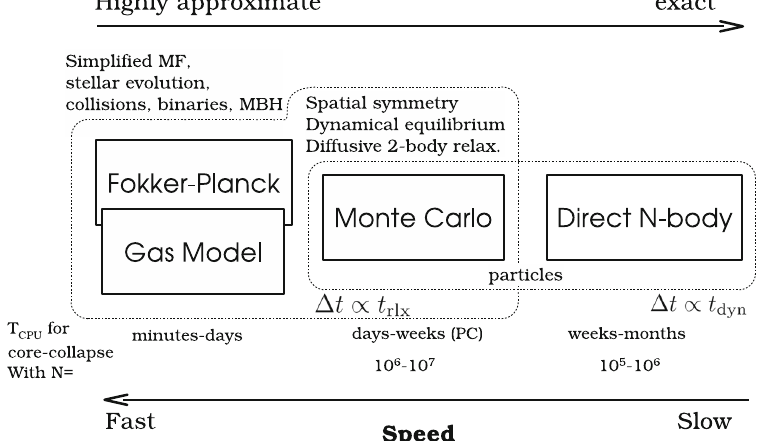
Fig. 63 The various methods used to study collisional stellar dynamics. In the case of direct N -body computations, the simulations require the use of either special-purpose hardware such as the GRAPEs, Beowulf clusters for the parallel version of Rainer Spurzem or Graphical Computing Units (GPUs). A version of the parallel code N -body6++ ported to GPU architecture has been developed, see Wang et